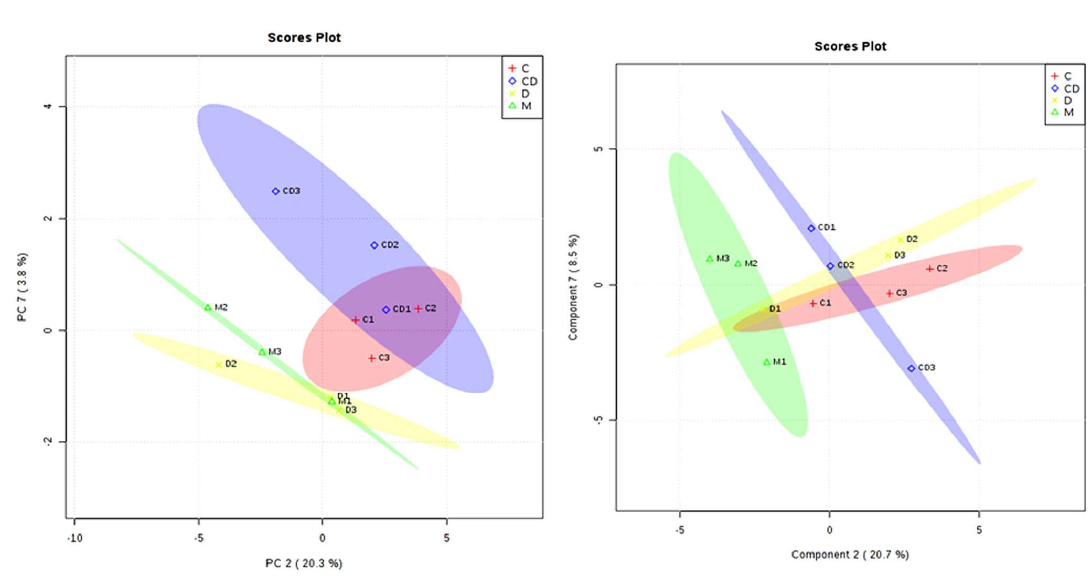
Figure 2. Score plots of PCA analysis and PLS-DA analysis showing best separations between